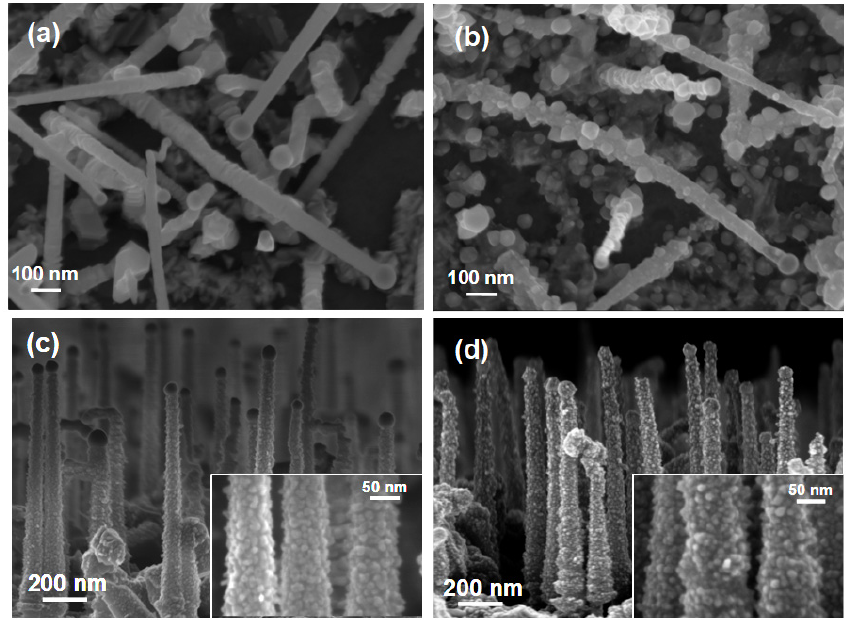
Figure 1. Scanning electron microscopy images of ( a ) as-grown ZnTe NWs; ( b ) oxidized ZnTe NWs; ( c ) as-grown ZnTe/Zn NWs; ( d ) oxidized ZnTe/Zn NWs.